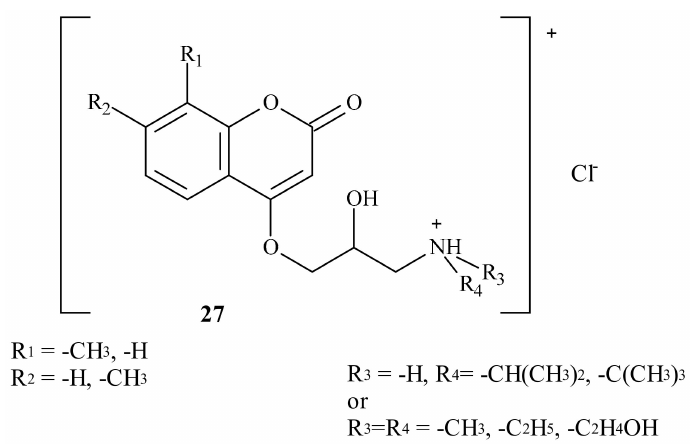
Figure 11. Methylated coumarins with an alkylaminohydroxypropoxy side chain.